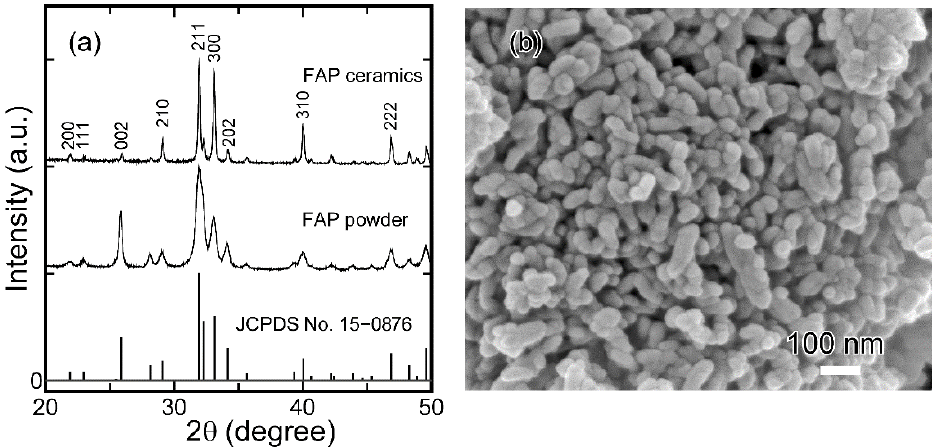
Figure 2. ( a ) XRD pattern of FAP powder and the FAP ceramic material sintered at 1000 °C. ( b ) FE- SEM image of the FAP powder.